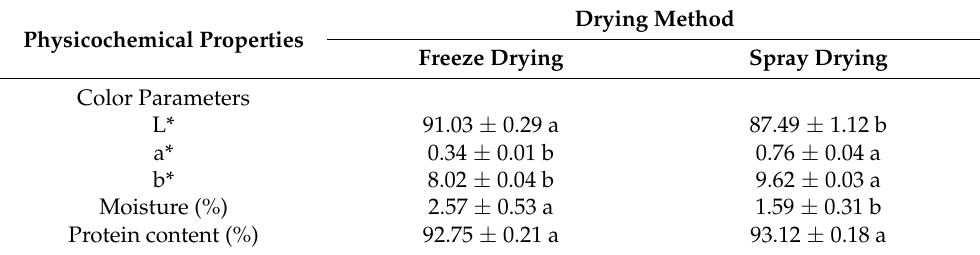
Table 1. Physicochemical properties of freeze-dried and spray-dried fish skin hydrolysate powder. Drying Method Physicochemical Properties Freeze Drying Spray Drying Color